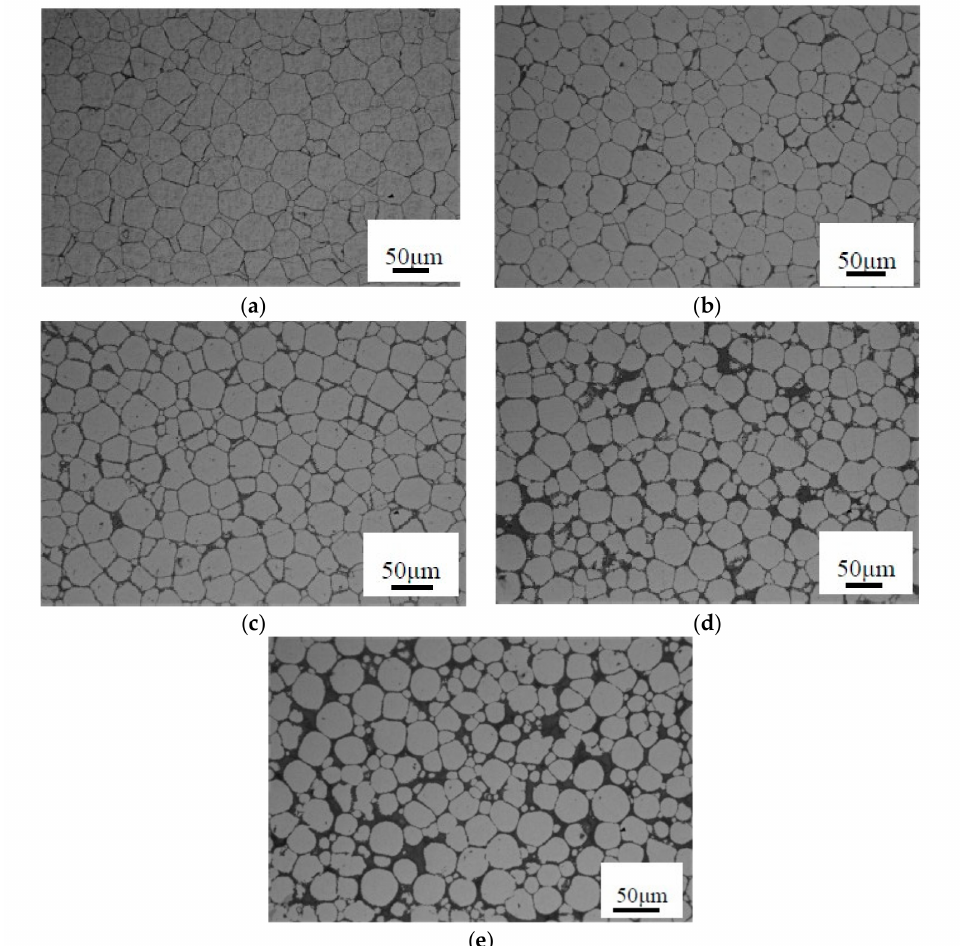
Figure 3. OM micrograph of AA6061 / N-SiCp composites sintered at 550 ◦ C with 1 ( a ), 3 ( b ), 5 ( c ), 10 ( d ) and 15 ( e ) vol.%